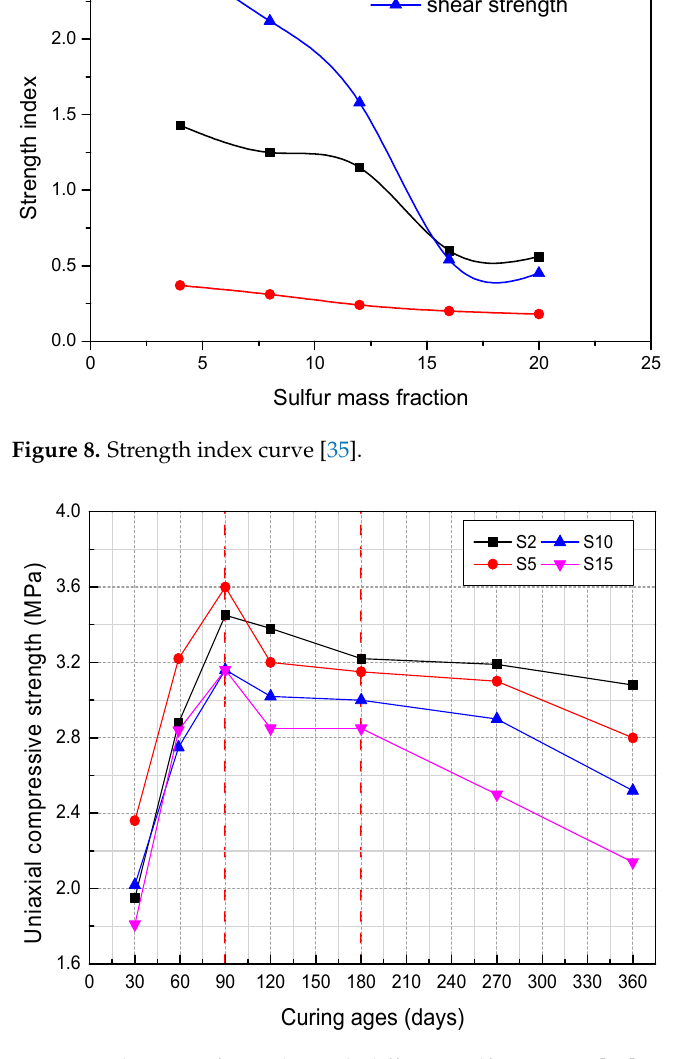
Figure 9. The UCS of samples with different sulfur content [37].